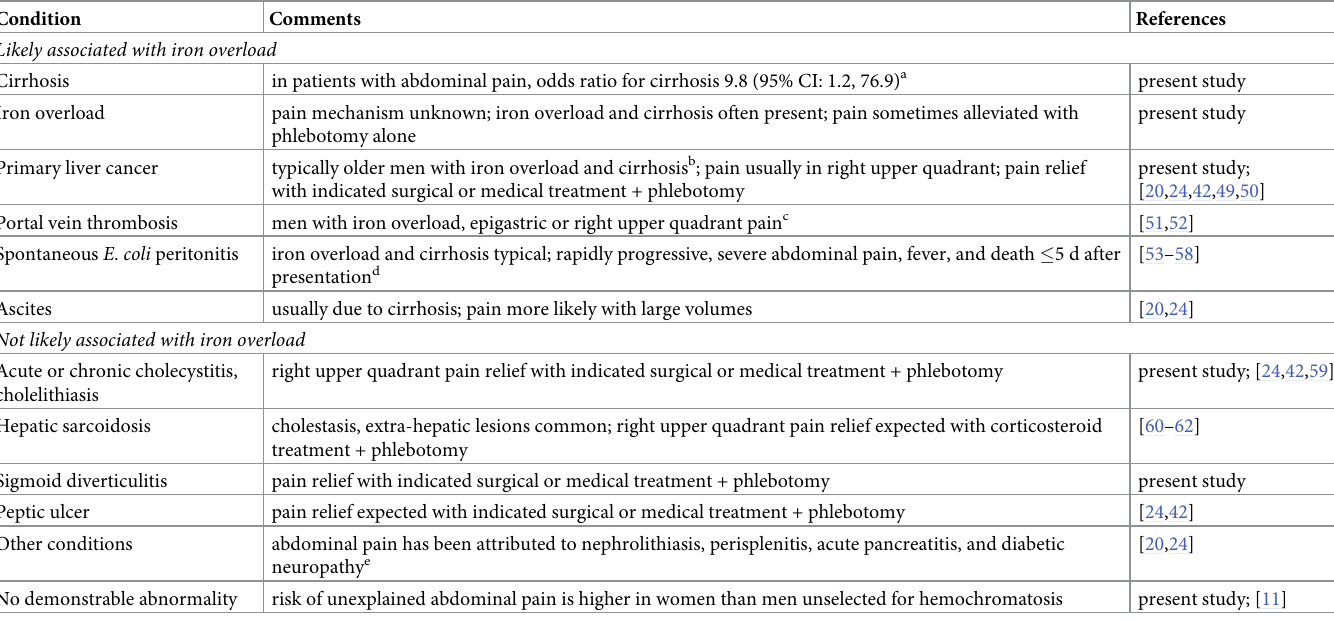
Table 5. Conditions associated with abdominal pain in adults with